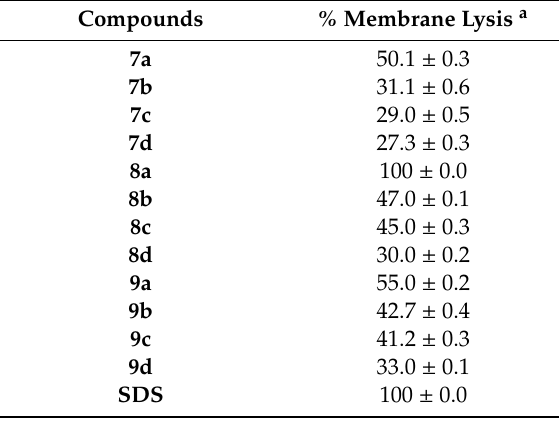
Table 2. Percentage of membrane lysis of the synthetic compounds 7a – d , 8a – d, and 9a – d